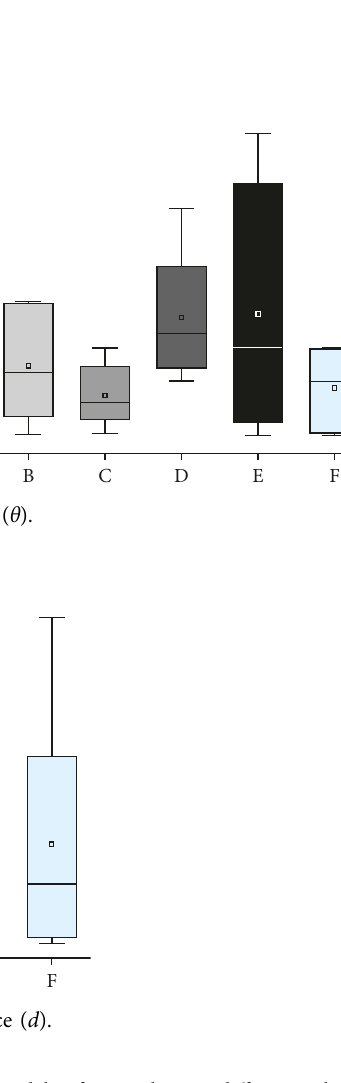
Table 4: Mean precision